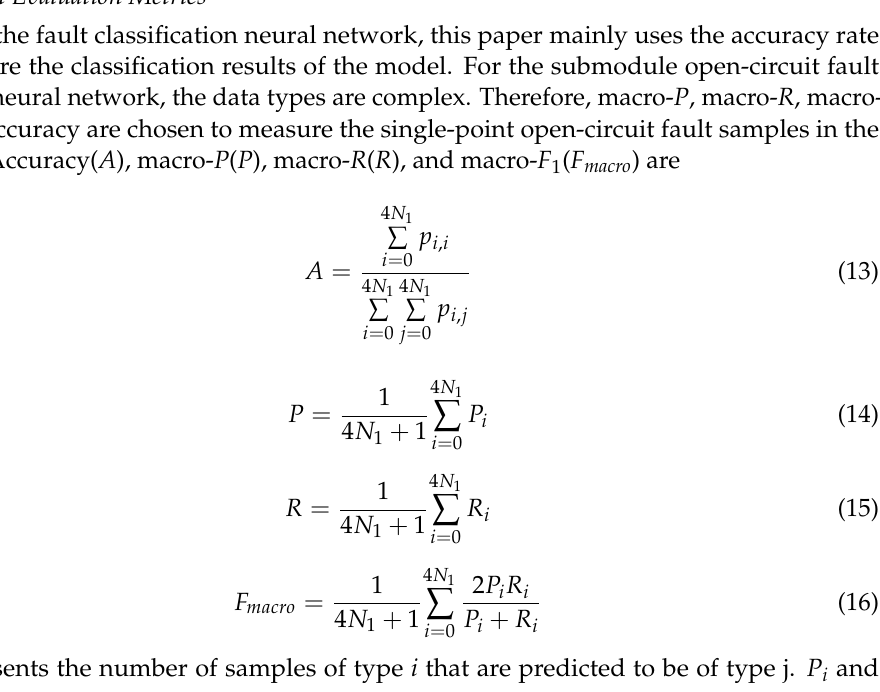
Figure 10. Schematic diagram of fault localization neural